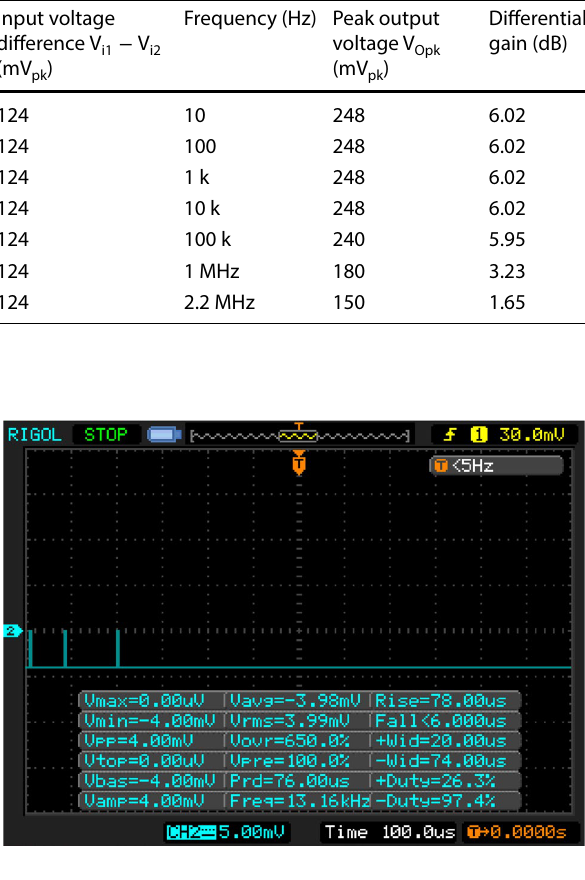
Table 1 Frequency verses differential output voltage